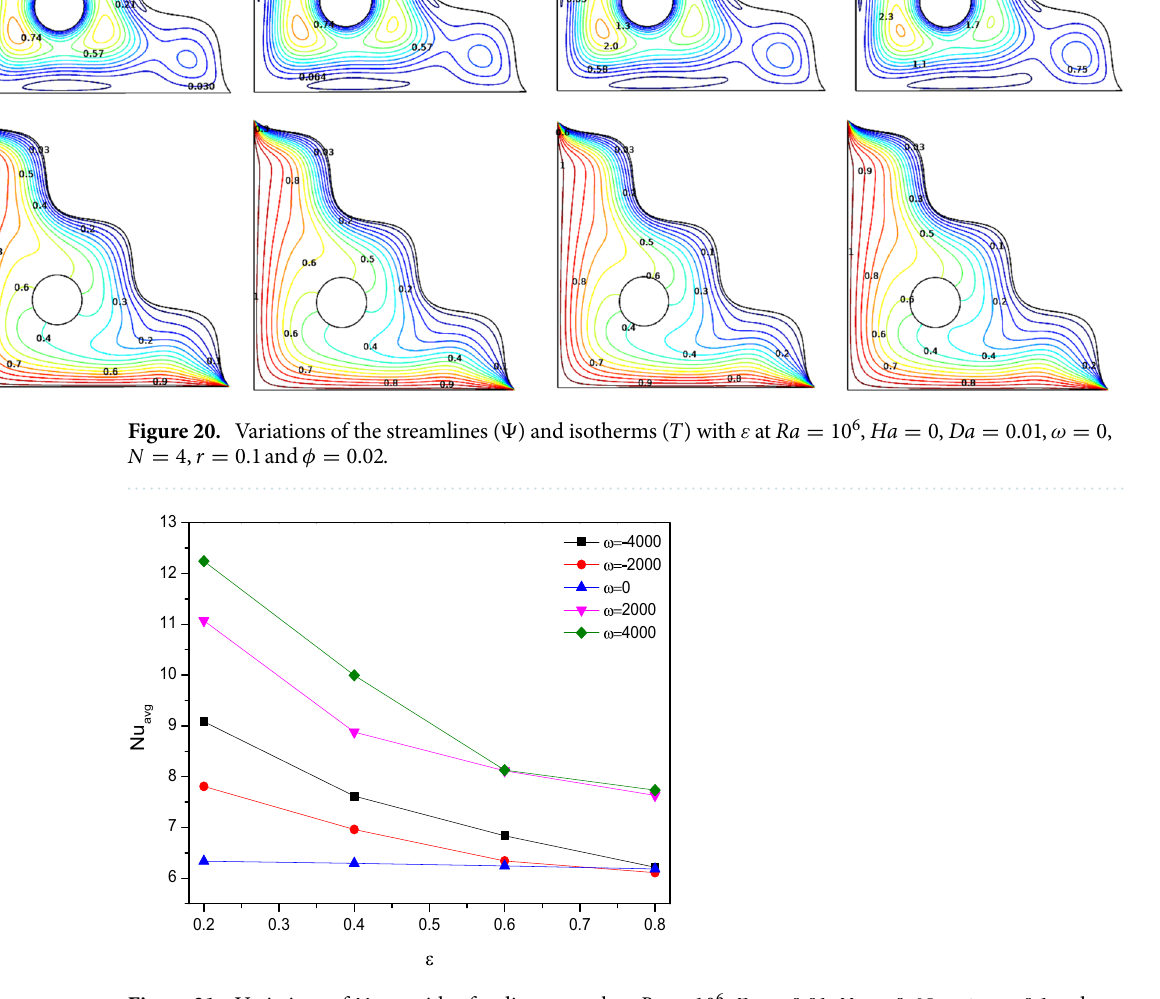
Figure 21. Variations of Nu avg with ε for diverse ω when Ra = 10 6 , Da = 0.01 , Ha = 0 , N = 4 , r = 0.1 and φ = 0.02